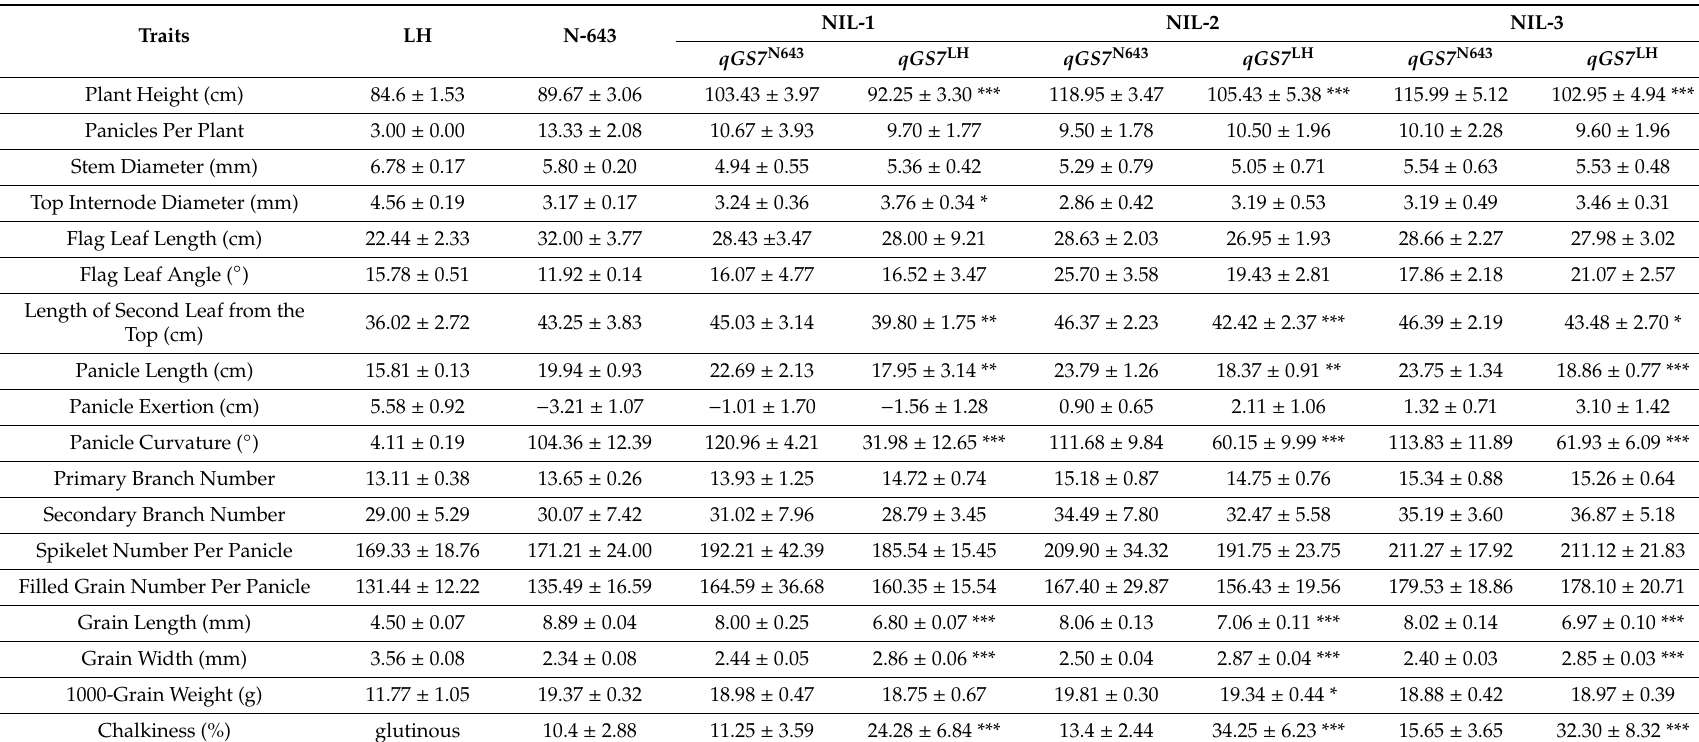
Table 4. Agronomic traits of paired NILs for qGS7